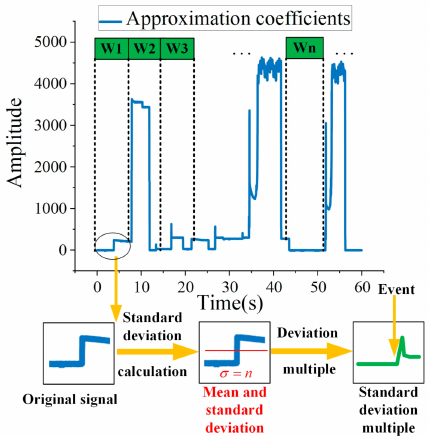
Figure 5. The standard deviation-based event detection.